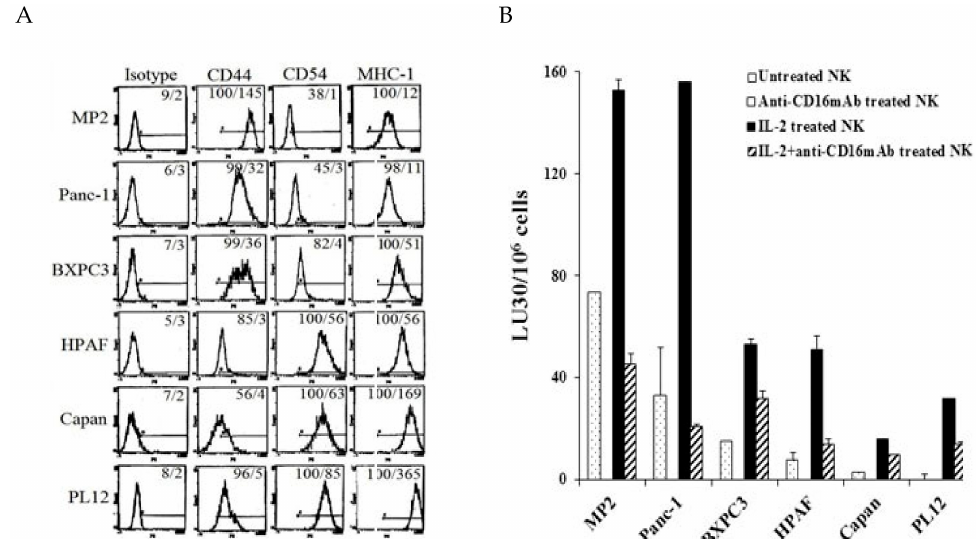
Figure 1. The stage of di ff erentiation in pancreatic tumors correlated with susceptibility to NK cell-mediated cytotoxicity. The surface receptor expression of CD44, CD54, and MHC-class I on pancreatic tumors were assessed by flow cytometry after staining with PE-conjugated antibodies. Isotype control antibodies were used to determine non-specific binding. Numbers in each histogram represent percent / mean channel fluorescence (MFI). ( A ) Freshly isolated NK cells were left untreated or treated with anti-CD16 mAb (3 µ g / mL), IL-2 (1000 U / mL), or the combination of anti-CD16 mAb (3 µ g / mL) and IL-2 (1000 U / mL) for 18 h before they were added to the cultures of 51 Cr labeled MP2, Panc-1, BXPC3, HPAF, Capan, or PL12. NK cell-mediated cytotoxicity was determined using 4